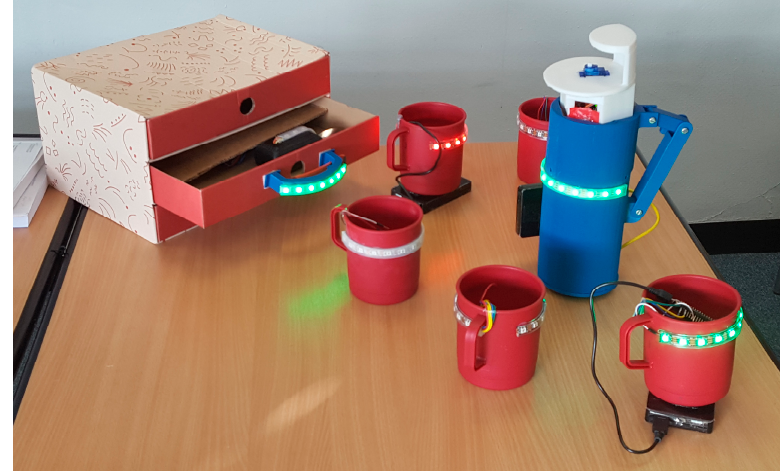
Figure 6. A collection of animate objects.